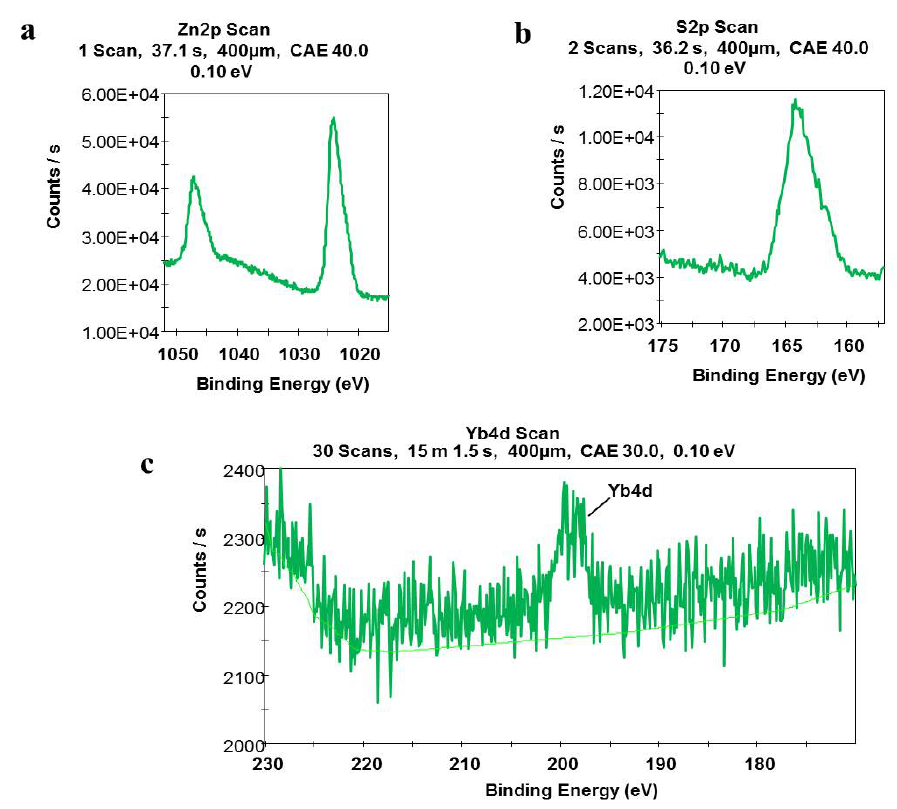
Fig. 3. XPS of 6% Yb 3+ -doped Figure 3. XPS of 6% Yb 3+ -doped ZnS.